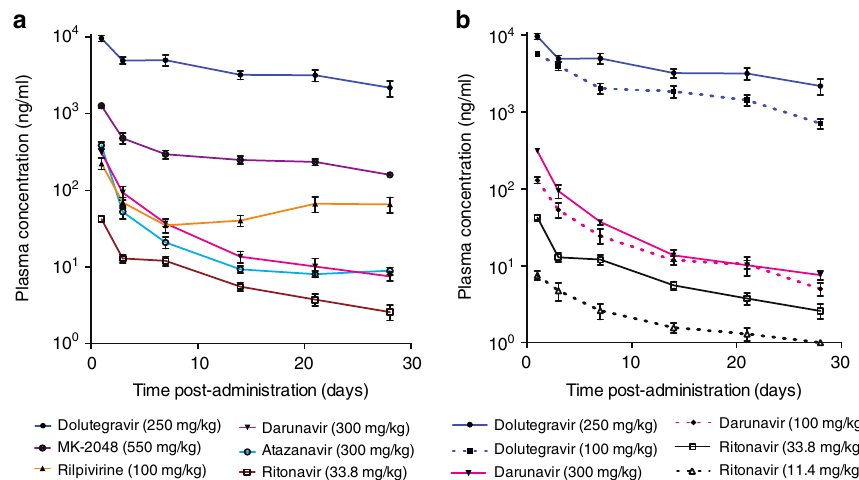
Fig. 7 Plasma concentration of various ARVs formulated as ISFI. ISFI formulations were administered subcutaneously to NSG mice ( n = 4) and plasma samples were collected longitudinally over 30 days. a Plasma concentrations of individual ARVs, b comparison of ISFI made using two different concentrations of dolutegravir (250 and 100 mg/kg), darunavir (300 and 100 mg/kg), and ritonavir (33.8 and 11.4 mg/kg). Mean plasma concentrations + s.e.m. are shown. Protein-adjusted IC90 (PA-IC90) values are: dolutegravir 64 ng/ml, MK-2048 33 ng/ml, rilpivirine 12 ng/ml, darunavir 2.4 ng/ml, and atazanavir 14 ng/ml. Since ritonavir is used as a booster in these formulations its IC90 is not indicated. Source data are provided as a Source Data fi